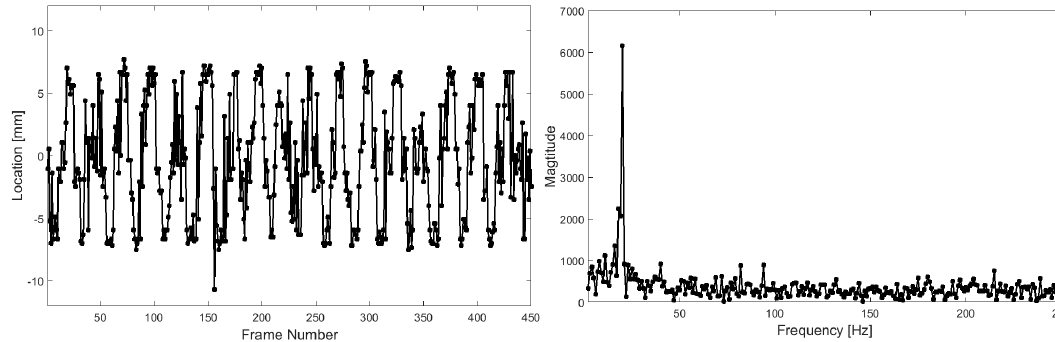
Figure 9. Radial position of flame tip ( left ) and its FFT results ( right ).